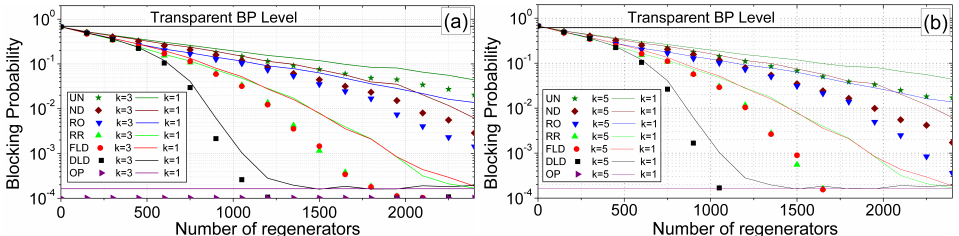
Figure 8. Blocking probability as a function of the total number of regenerators in CoreNet topology using k-shortest path routing algorithm for: ( a ) k = 3; ( b ) k = 5, each compared against the k = 1